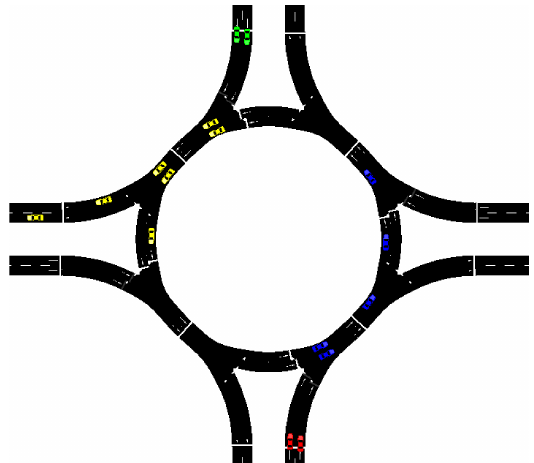
Figure 14. Snapshot of the simulation. The vehicles in the north (green) and south (red) are arriving just after the vehicles from west (blue) and east (yellow) have passed their respective entries to the